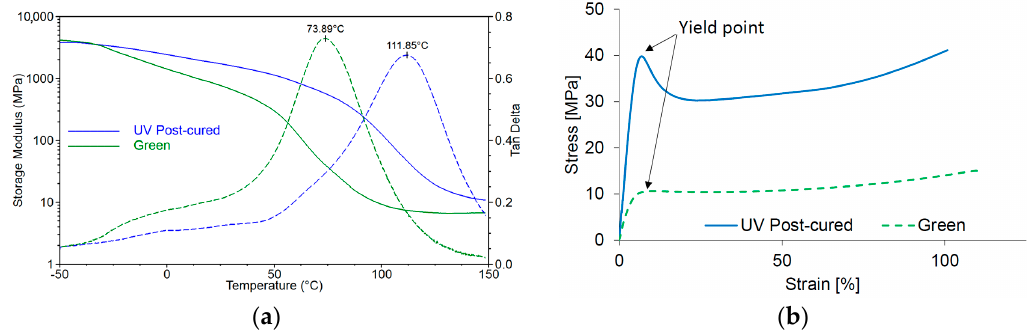
Figure 10. Testing of DLP-printed samples (1.18 wt % TPO-L): ( a ) Storage modulus ( solid line ) and the tan δ -curve ( dashed line ) for green and post-cured samples. The peak of the tan δ -curve was analyzed; ( b ) Stress-strain curves from tensile tests. The samples show a yield point, which was used for the analysis.